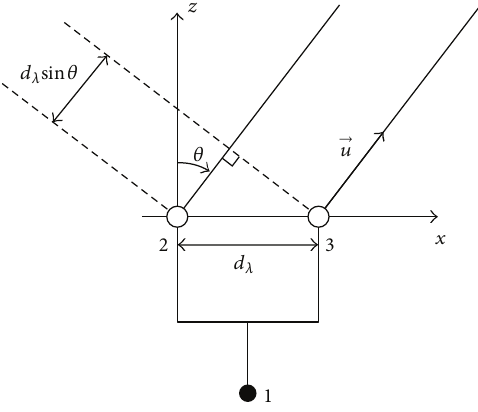
Figure 1: 2-element linear array parameters definition.